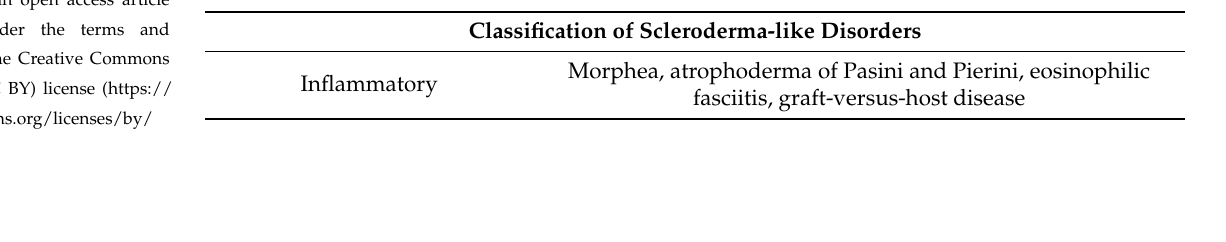
Table 1. Classification of scleroderma-like